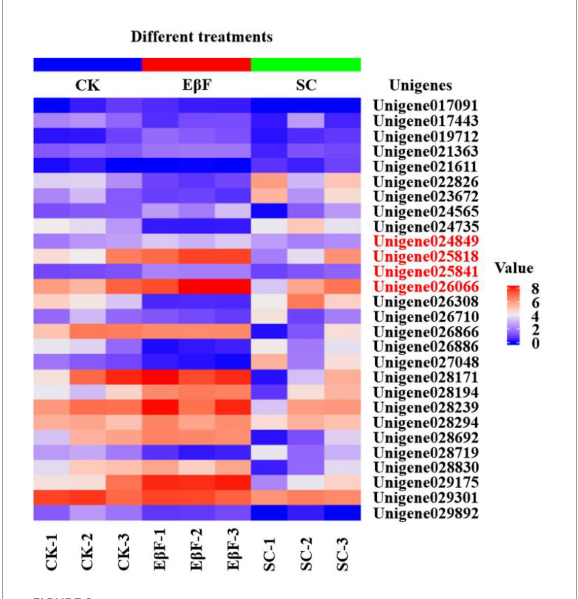
FIGURE2 The heat map showed the relative expression level of all differentially expressed juvenile hormone-related unigenes in S. exigua larvae after E β F treatments at doses of 4 g/kg. CK (blank control) and SC (solvent control) were set as controls. The concentrations of E β F treatments were set as 4 g/kg; the units of E β F treatment as g/kg in all treatment groups mean the mass ratio of E β F/artificial diet. The value denotes the value of log2 (FPKM + 1). The unigenes for further study using the RT-qPCR were marked with red